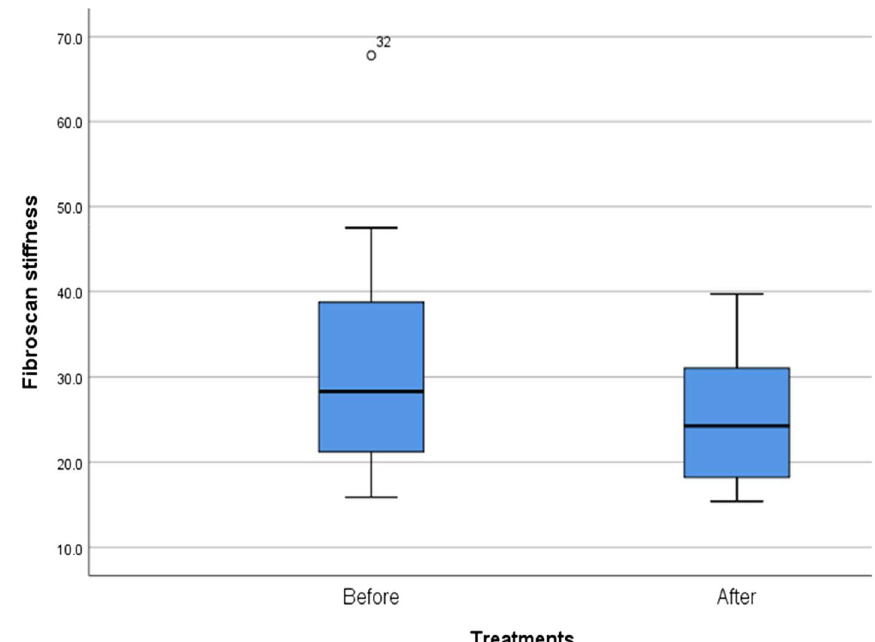
Fig. 3 The liver stiffness Boxplot between before‑ and after‑treatment in patients within 10 ‑ 15 KPa category